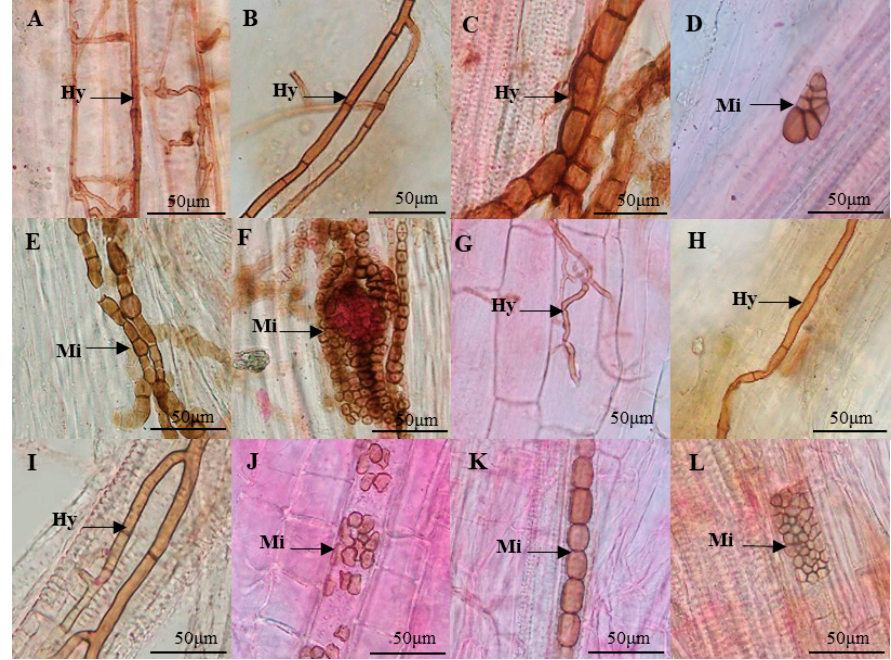
Figure 1. Dark septate endophytes associated with the roots of L. ruthenicum . Arrows indicate the following: Hy, dark septate endophytes (DSE) hyphae and Mi, DSE microsclerotia. Images are of roots sampled from Anxi ( A – F ) and Minqin ( G – L ). ( A , D , G , J ) are sampled in July, ( B , E , H , K ) are sampled in September, and ( C , F , I , L ) are sampled in December. With the change of seasons, the diameter of hyphae became thicker, the septum be-